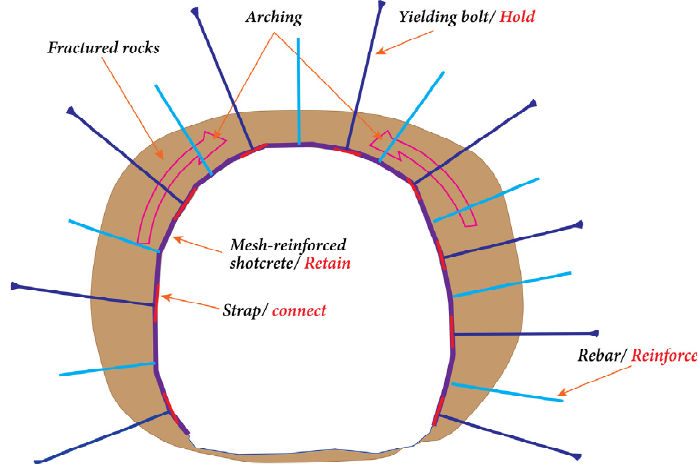
Figure 15. Required support functions in burst-prone ground (modified after ref. [202]).